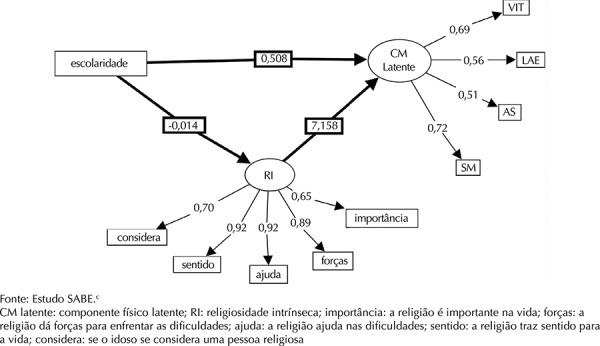
Síntese da modelagem de equações estruturais para o componente mental, sexo masculino. São Paulo, SP, 2006.